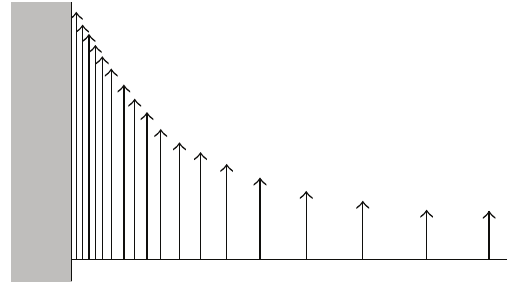
Figure 5: Velocity profile near the wall.